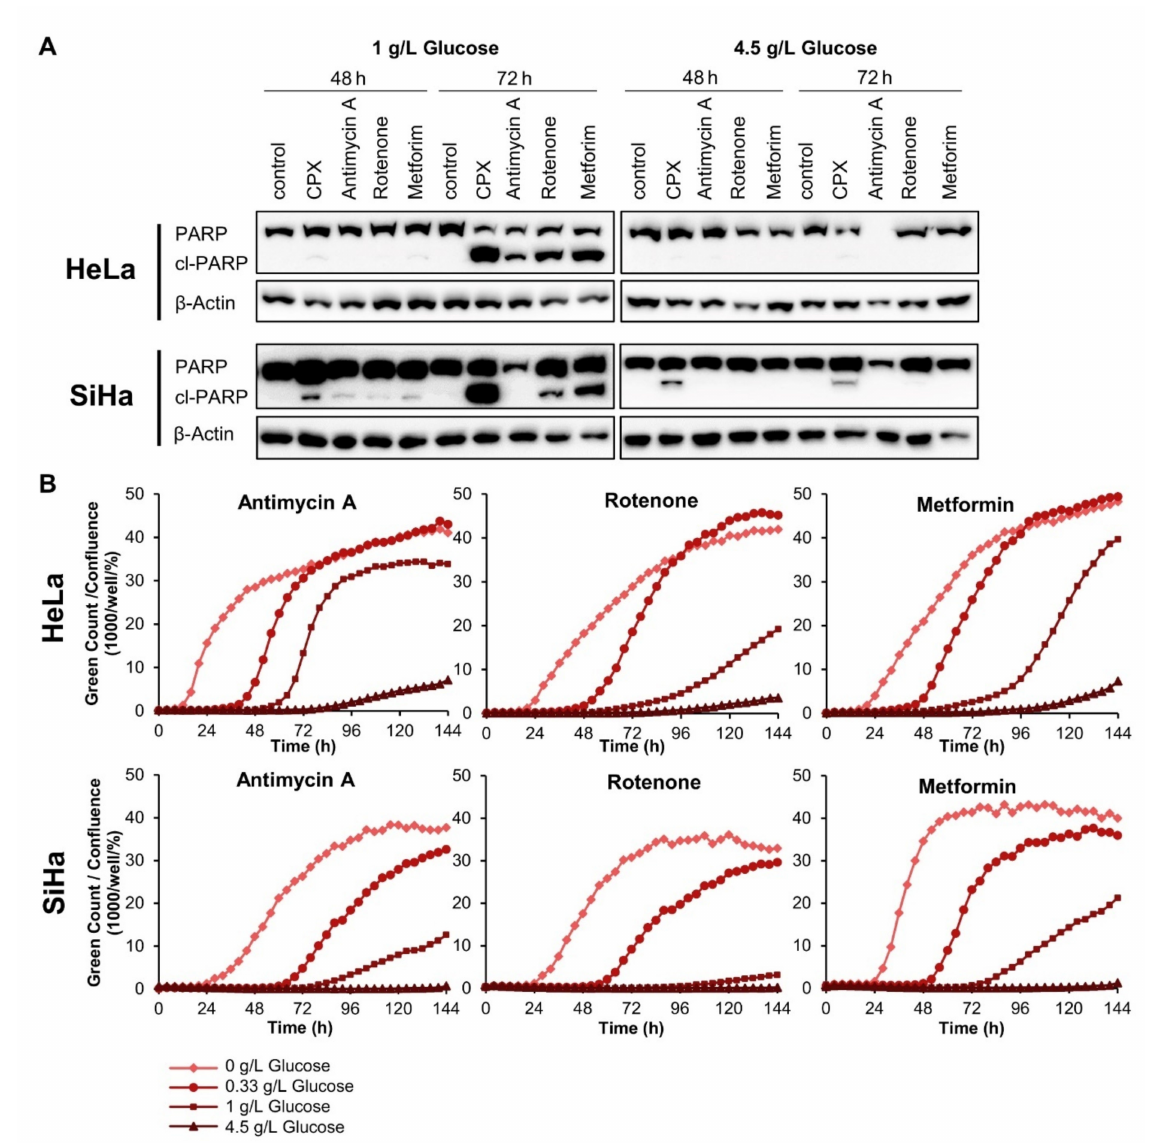
Figure 4. OXPHOS inhibitors induce glucose-dependent apoptosis in cervical cancer cells. ( A ) Immunoblot analyses of PARP and cl-PARP levels in HeLa or SiHa cells after 48 or 72 h of treatment with the indicated OXPHOS inhibitors under 1 g/L or 4.5 g/L glucose. The following drug concentrations were used: 10 µ M CPX; 5 nM (HeLa)/ 10 nM (SiHa) antimycin A; 20 nM rotenone; 2.5 mM (HeLa)/ 7.5 mM (SiHa) metformin. β -Actin: loading control. ( B ) HeLa mKate2 (upper panels) or SiHa mKate2 (lower panels) cells were treated for 144 h with OXPHOS inhibitors under the indicated glucose concentrations in the presence of 100 nM IncuCyte ® Cytotox Green Reagent. Green counts indicating dead cells were quantified every 4 h by live-cell imaging, and normalized to cell confluence. The following drug concentrations were used: 10 nM antimycin A; 20 nM rotenone; 2.5 mM (HeLa)/ 5 mM (SiHa)